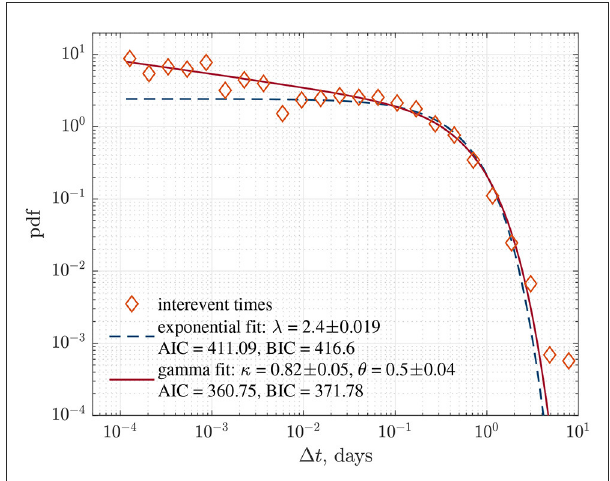
FIGURE5 The distribution of interevent times between successive events for all events above magnitude m min 0.94. The fits of the = − exponential distribution (blue dashed curve) and the gamma distribution (solid red curve) are given with corresponding model parameters and the values of AIC and BIC. The parameter uncertainties are reported with 95% confidence intervals.